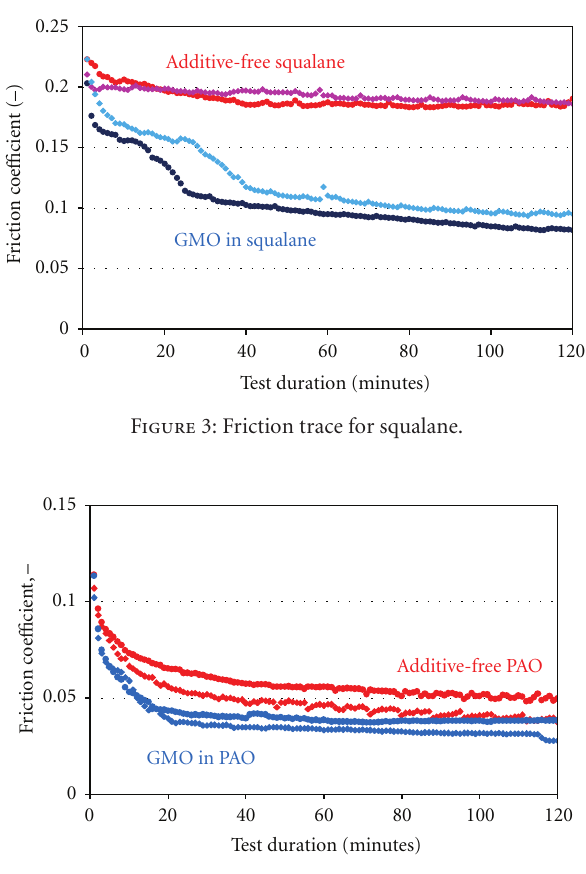
Figure 4: Friction trace for